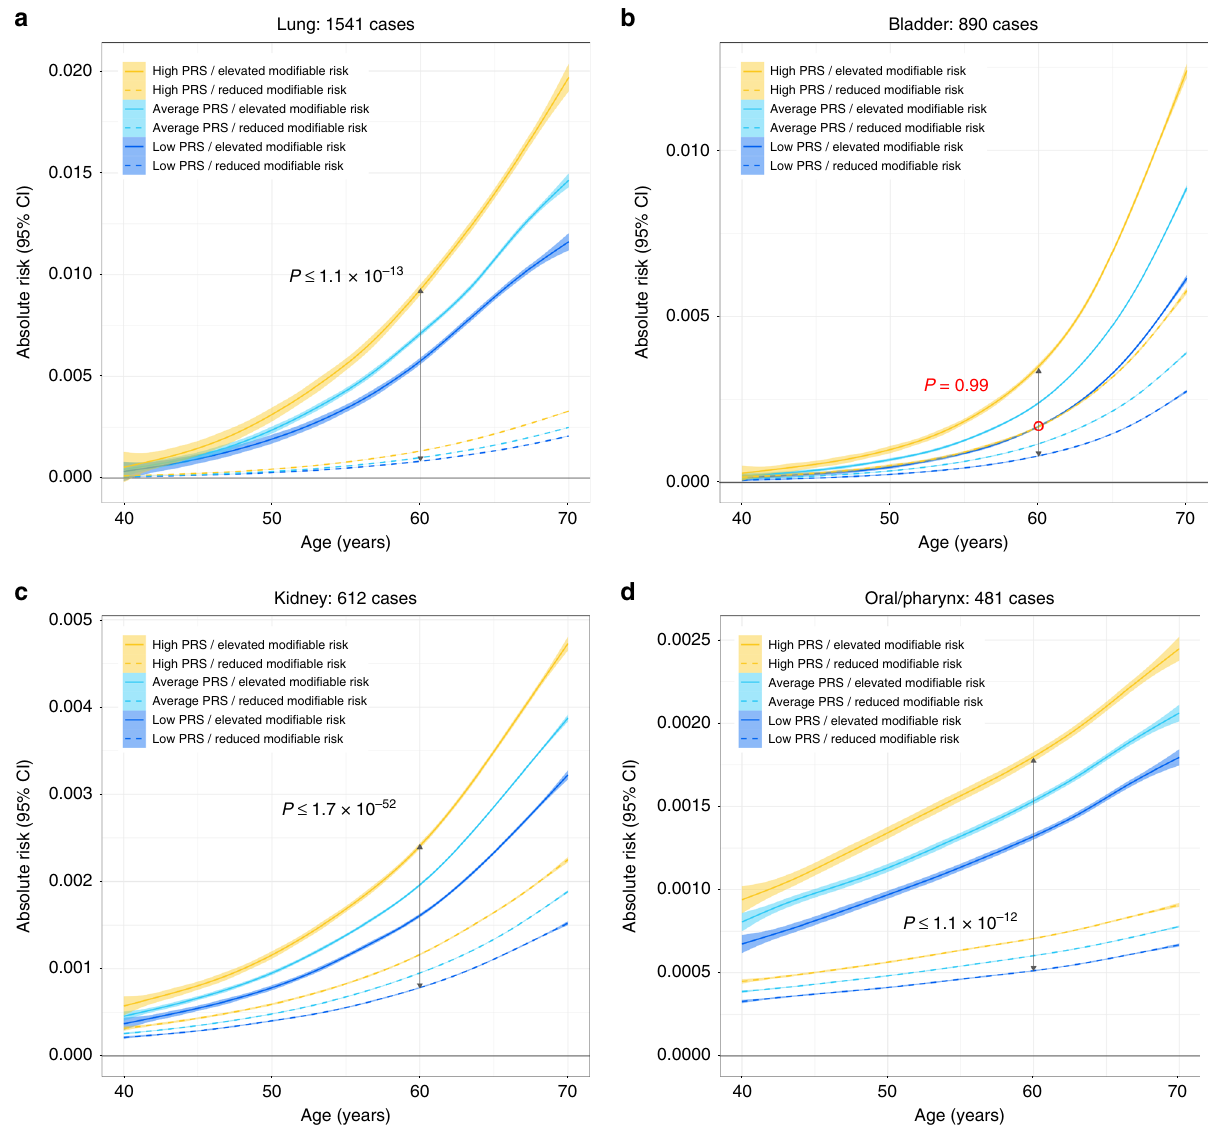
Fig. 5 Predicted 5-year absolute risk trajectories across strata de fi ned by modi fi able risk factors and percentiles of the polygenic risk score (PRS) distribution. Low PRS corresponds to ≤ 20th percentile, average PRS is de fi ned as >20th to <80th percentile, and high PRS includes individuals in the ≥ 80th percentile of the normalized genetic risk score distribution. Individuals below the median of the modi fi able risk factor distribution were classi fi ed as having reduced risk, whereas those above the median had elevated risk. P values for differences in mean absolute risk in each stratum at age 60 for a lung, b bladder, c kidney, and d oral/pharynx cancers are based on t -tests (two